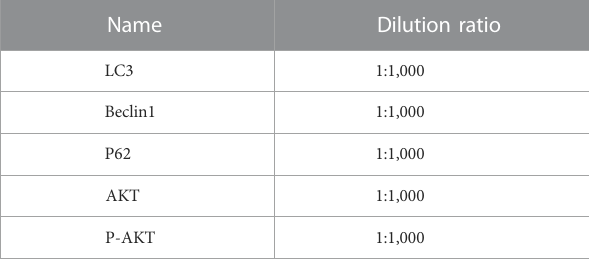
TABLE 4 Diluted concentration of antibody.